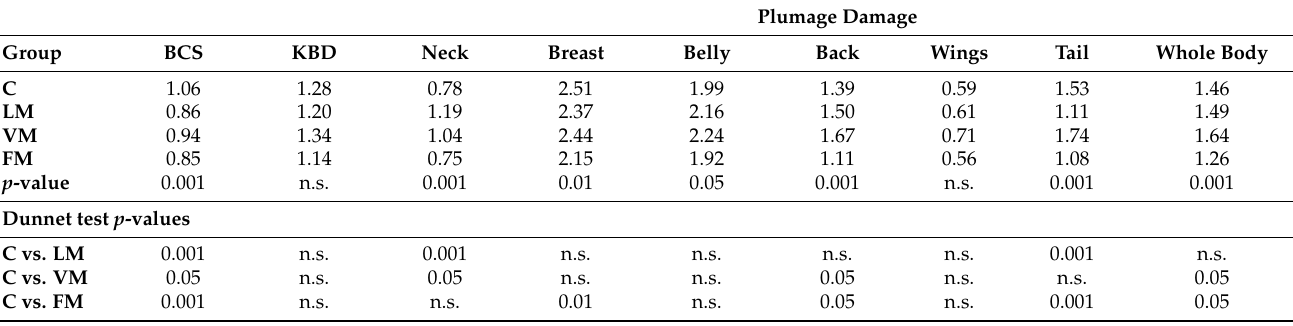
Table 1. Average scores of the welfare parameters assessed at the end of the trial (78 weeks of age) (C = Control, LM = Longitudinal Movement, VM = Vertical Movement, FM = Freedom of Movement, BCS = Body Condition Score, KBD = Keel Bone Damage). The whole body score was calculated as the average of all the body areas assessed. p -value: indicates the statistical significance of the differences among the 4 experimental groups, considered altogether. Dunnet test p -values: they indicate the significance of differences between the control group and each of the groups with structural modifications, taken individually (C vs. LM, C vs. VM and C vs. FM). Plumage